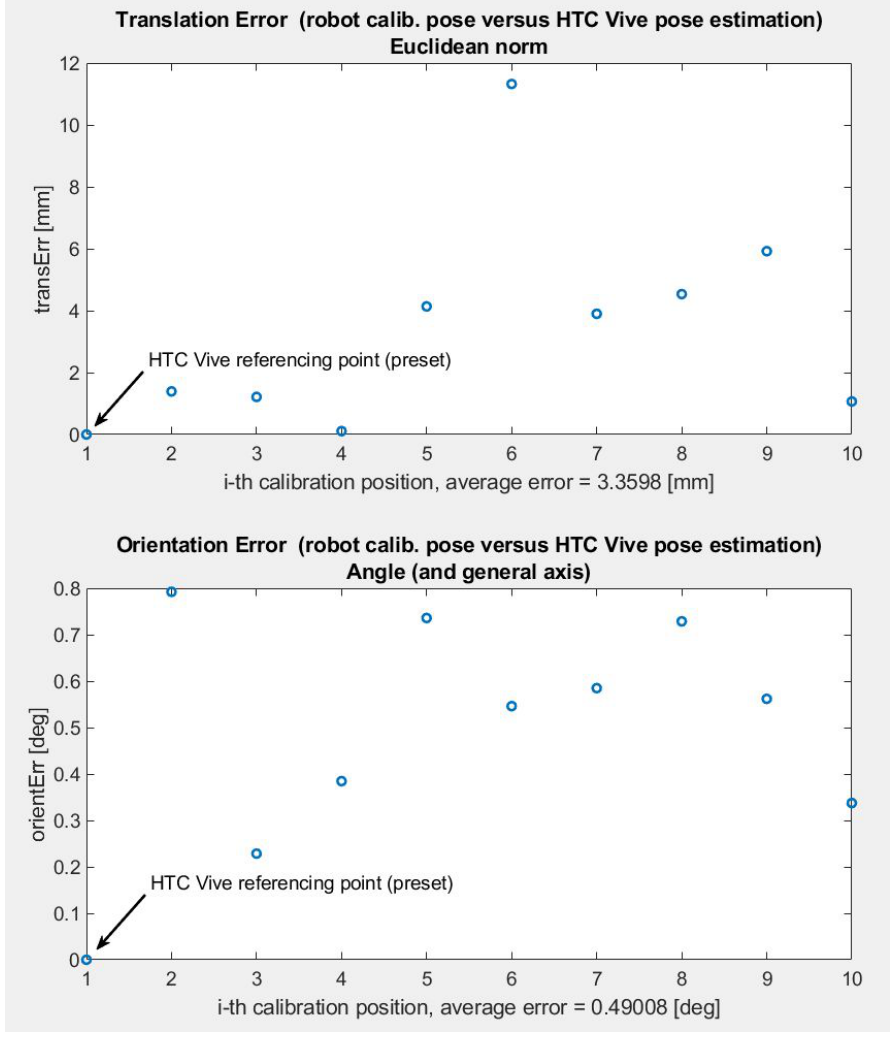
Figure 10. Tracking error evaluation—static pose estimation test using discrete